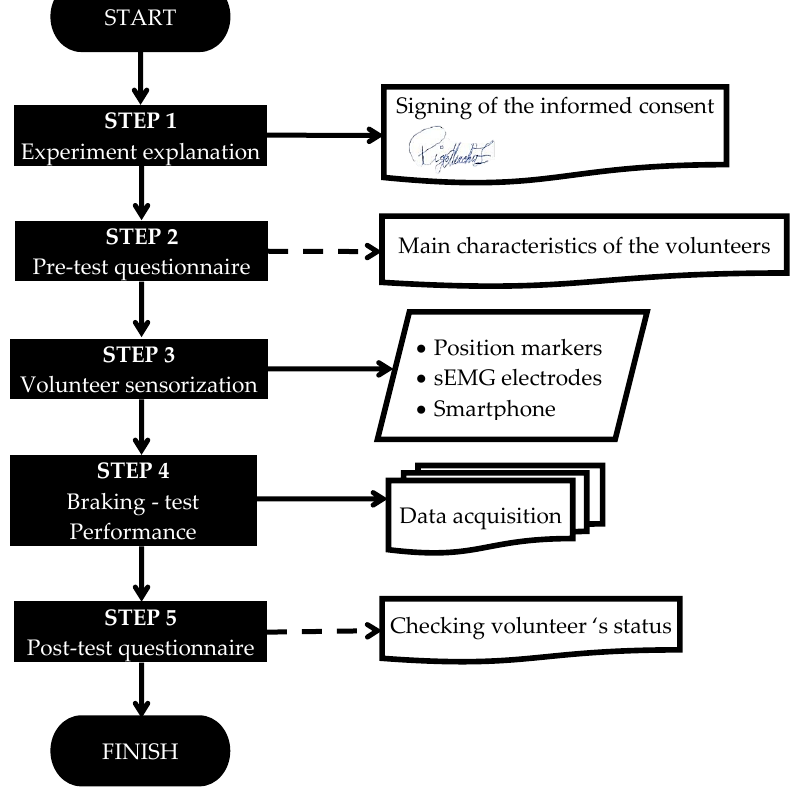
Figure 1. Steps of the experiment.